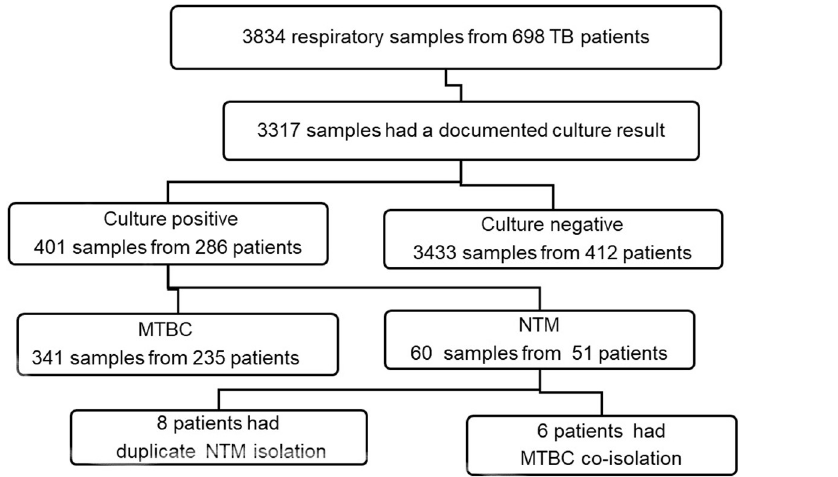
Fig 1. Flow chart of PTB patient and sample identification with NTM and